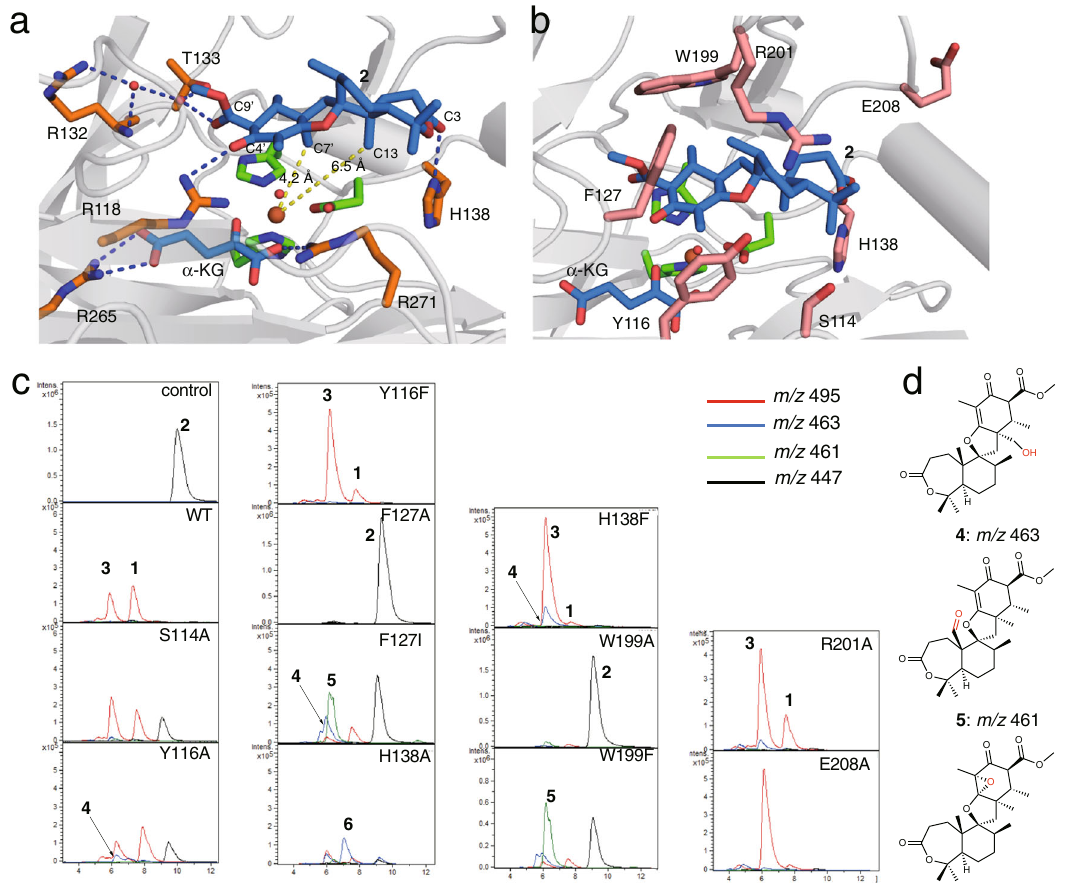
Fig. 5 The binding modes of 2 and α -KG in the active site of NvfI and enzyme reactions of NvfI variants. a Close-up view of the active site of NvfI in complex with 2 and α -KG. b The mutated residues in the active site of NvfI. The substrates 2 and α -KG are depicted by magenta stick models. The catalytic triad is represented by a green stick model. Dashed blue lines represent hydrogen bonds. The dashed yellow line shows the distance between C7 ’ -Fe and C13-Fe. Water molecules are represented by red nb_spheres. c LC-MS charts of the enzyme reactions of NvfI variants. d Structures of shunt products.